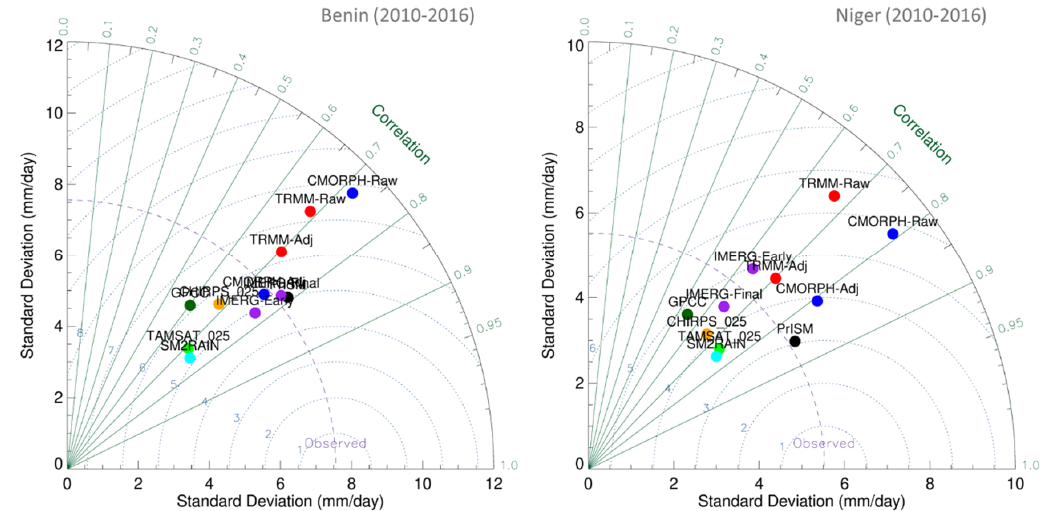
Figure 5. Taylor diagrams for the Benin ( left ) and Niger ( right ) 0.25° sites and the 2010–2016 period (except for IMERG, 2015–2016) and the 11 precipitation products. Color dots refer to the different products (blue = CMORPH, red = TRMM, purple = IMERG, green = TAMSAT_025, cyan = SM2RAIN, orange = GPCC and black = PrISM).